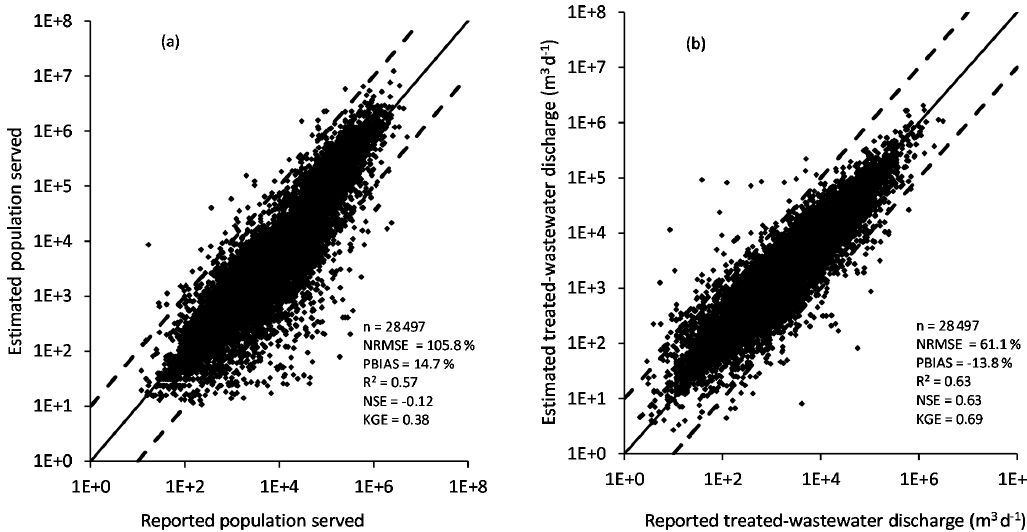
Figure 4. Evaluation of the method used to estimate missing attributes (see text for more explanations): population served (a) and treated- wastewater discharge (b) . n is the number of records; NRMSE is the normalized root mean square error; PBIAS is the percent bias; NSE is the Nash–Sutcliffe efficiency; and KGE is the Kling–Gupta efficiency. The solid line represents the 1 : 1 line, and the dashed lines represent the error lines of 1 order of magnitude. Table 5. Level of treatment according to the HydroWASTE database. The reported values are provided by the national datasets compiled, and the estimated values were produced using methods described in Sect. 2.1.4. “Correct prediction of reported treatment level” refers to the percentage of correct classifications using our prediction